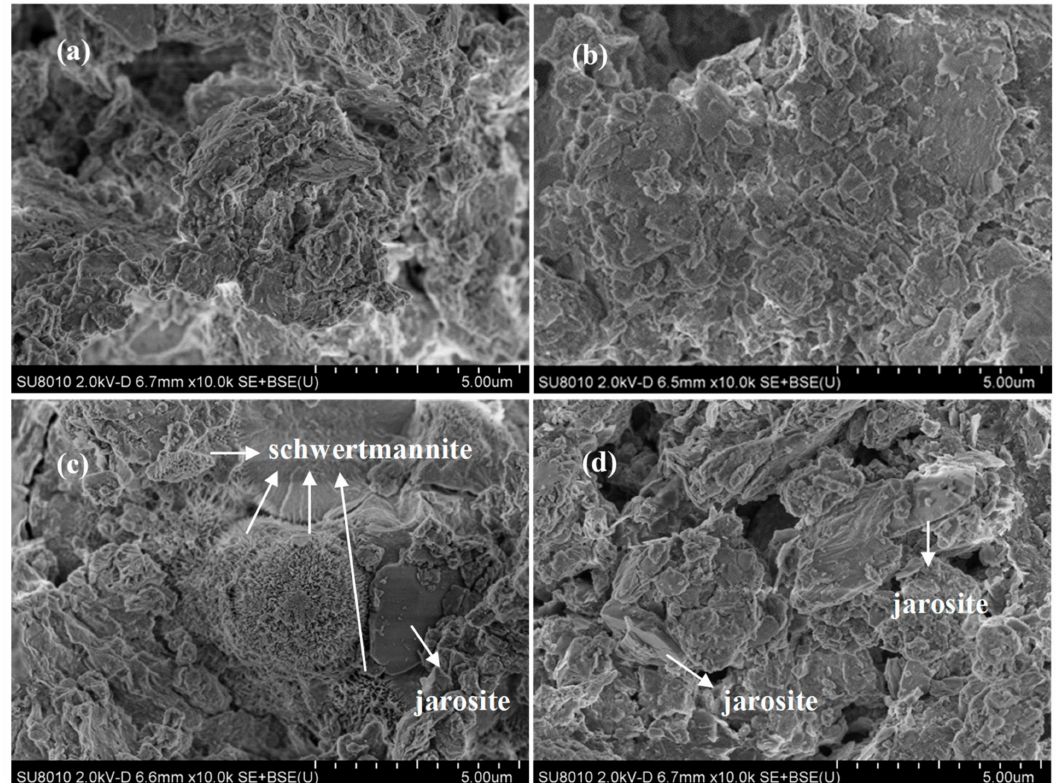
Figure 2. The scanning electron microscope (SEM) photos of municipal sewage sludge with different treatments at 28 ◦ C and 180 rpm for 120 h: ( a ) 540 mL sludge + 60 mL deionized water; ( b ) 540 mL sludge + 60 mL deionized water + 10 g · L − 1 quartz sand; ( c ) 540 mL sludge + 60 mL A. ferrooxidans LX5 + 44.2 g · L − 1 FeSO 4 · 7H 2 O; ( d ) 540 mL sludge + 60 mL A. ferrooxidans LX5 + 44.2 g · L − 1 FeSO 4 · 7H 2 O + 10 g · L − 1 quartz sand (initial pH = 7.22, SRF = 12.4 × 10 12 m · kg − 1 , A. ferrooxidans LX5 density = 5 × 10 7 cells · mL − 1